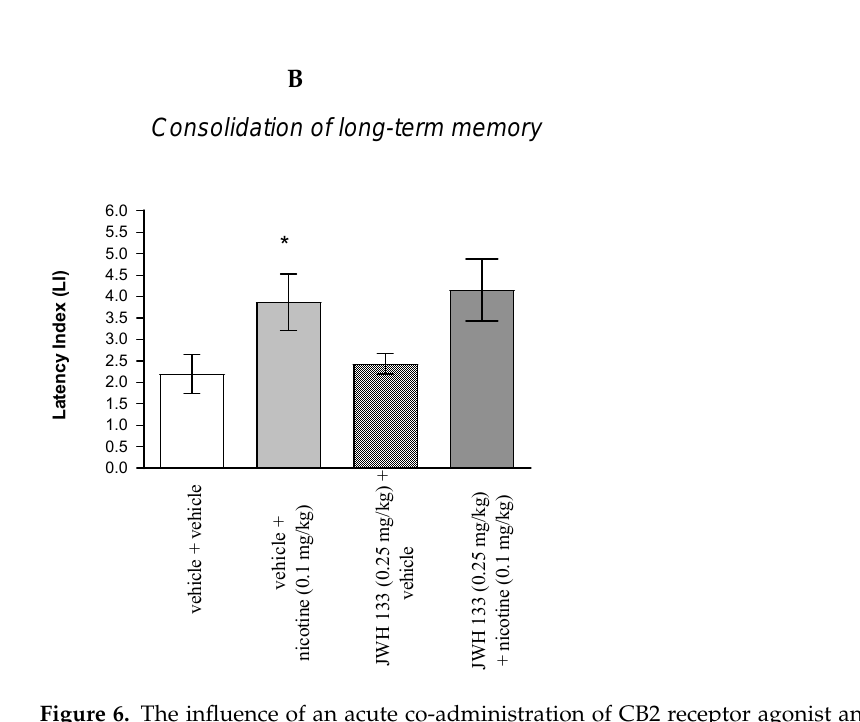
Figure 6. The influence of an acute co-administration of CB2 receptor agonist and effective (pro-cognitive) dose of nicotine on the cognition-related responses expressed as latency index (LI) during the acquisition ( A ) and consolidation ( B ) of memory using the PA test in mice. * p < 0.05 vs. vehicle/vehicle-treated mice; * p < 0.05 vs. vehicle/vehicle-treated mice. Non-effective doses of the CB2 receptor agonist (JWH 133, 0.25 mg/kg) or vehicle were administered 15 min prior to the pro-cognitive dose of cholinergic receptor